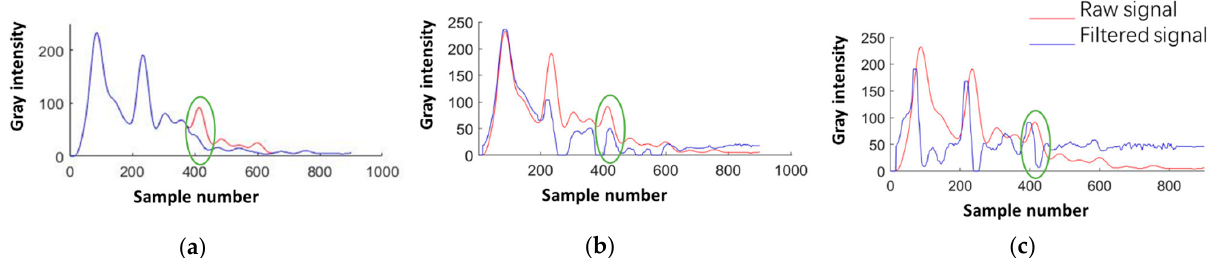
Figure 19. The reflection sequence of one ping. ( a ) Result by our proposed method. ( b ) Result by predictive deconvolution in which the predictive step is instantaneous seawater depth. ( c ) Result by predictive deconvolution in which the predictive step equals 25. The red lines represent the raw signal. The blue lines represent the signal after multiples suppression method. The green ellipses represent the multiples.